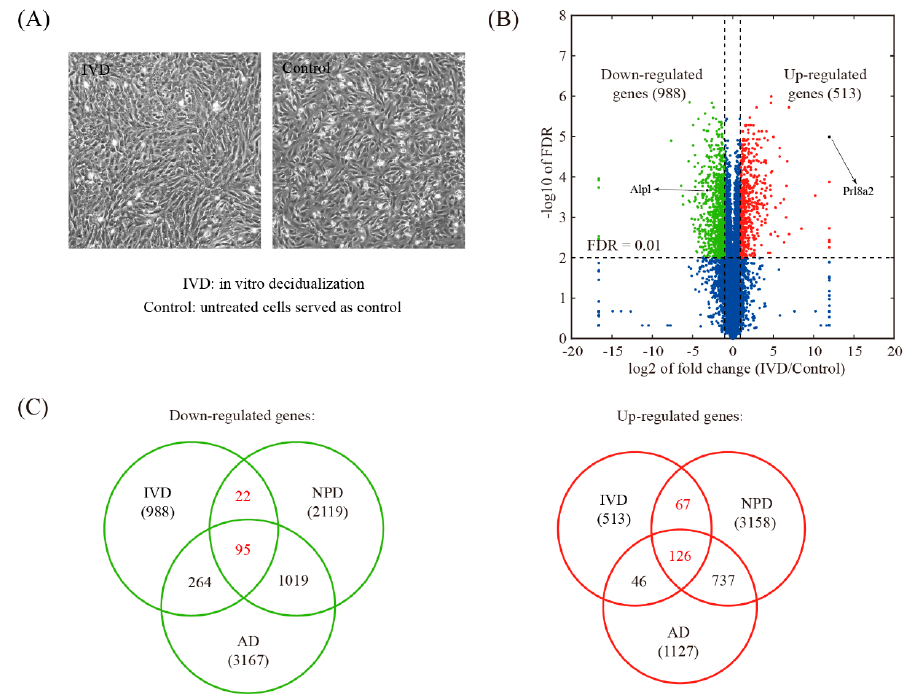
Figure 6. Identification of changed genes in the in vitro decidualization (IVD) model. ( A ) A view of morphological changes in cultured endometrial stromal cells during the IVD process. ( B ) Volcano plot showing the comparison between IVD and control. The threshold values for differentially expressed genes were: fold change >2 and FDR < 0.01. ( C ) Venn diagram showing the overlap of down-regulated genes and up-regulated genes and between the NPD model, the AD model, and the IVD model.